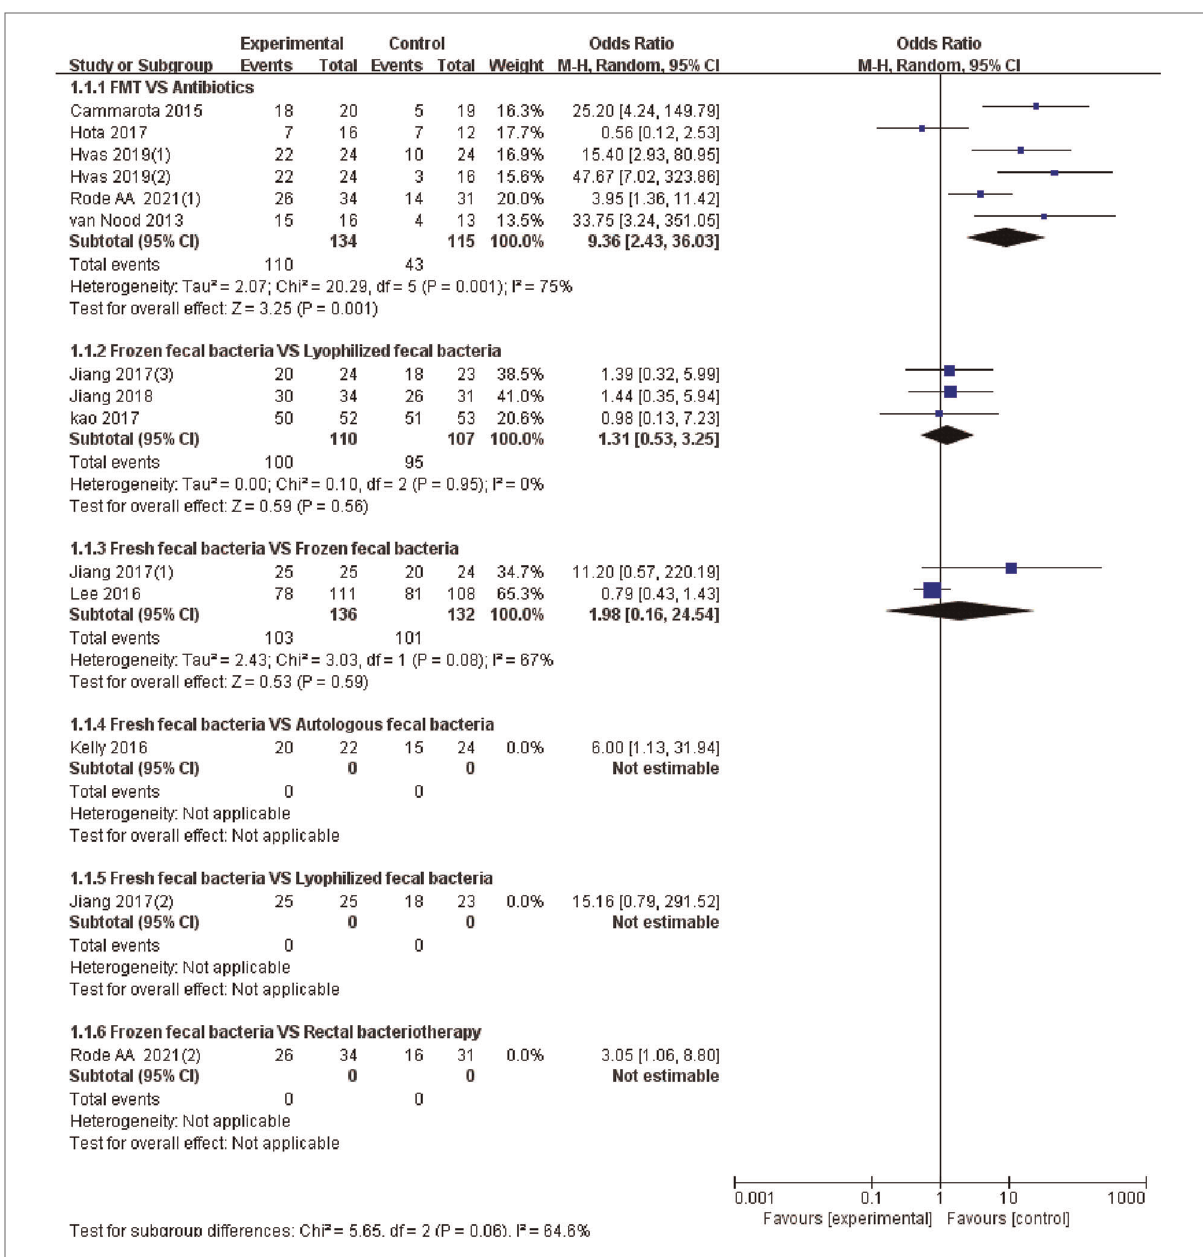
FIGURE 3 Forest of cure rate of different FMT for rCDI associated